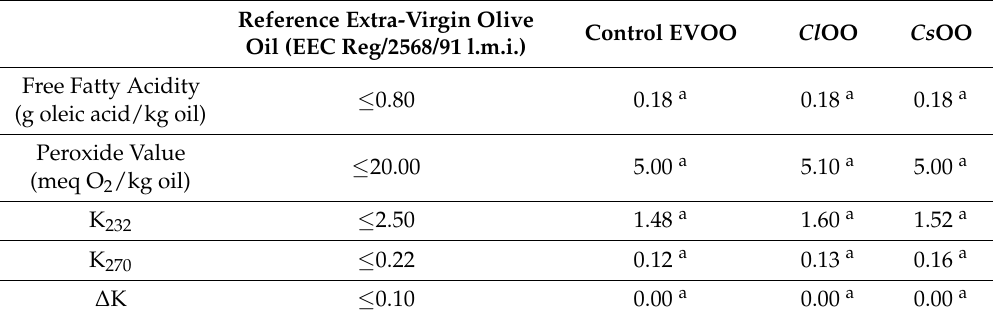
Table 4. Chemical characterisation of control extra-virgin olive oil (Control EVOO), lemon olive oil ( Citrus limon olive oil Cl OO), orange olive oil ( Citrus sinensis olive oil Cs OO) and legal limits for extra-virgin olive oil according to the regulation EEC/2568/91 and later modifications and integrations [14]. Reference Extra-Virgin Olive Oil (EEC Reg/2568/91 l.m.i.)